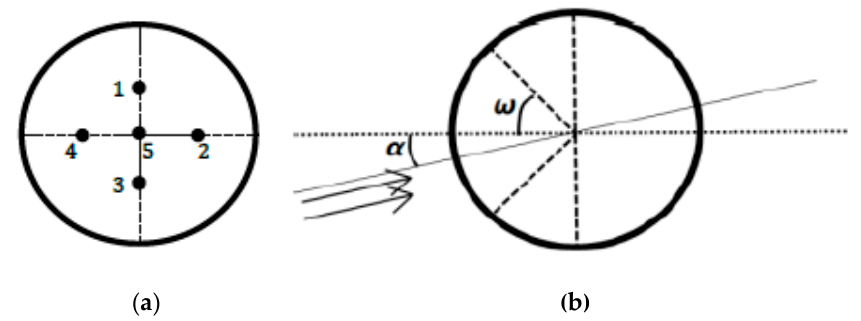
Figure 7. The five-hole probe; ( a ) front view; and ( b ) right view.